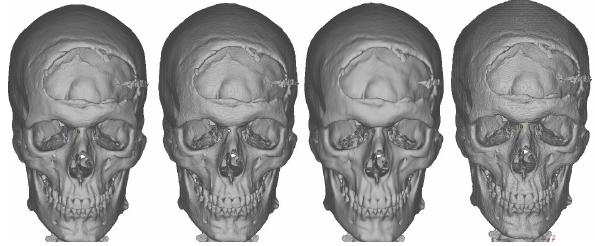
Fig. 2. Examples of models based on tomographic data, from left to right the results of the programs Mimics, DICOM Viewer, 3DSlicer, InVesalius.